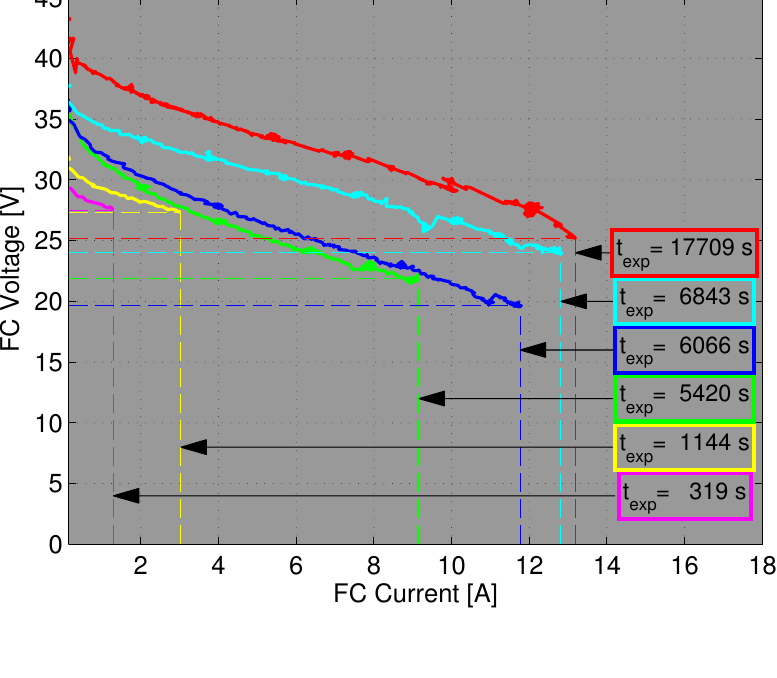
Figure 13. Fuel-cell V-I static characteristic corresponding to the reactivation of Figure